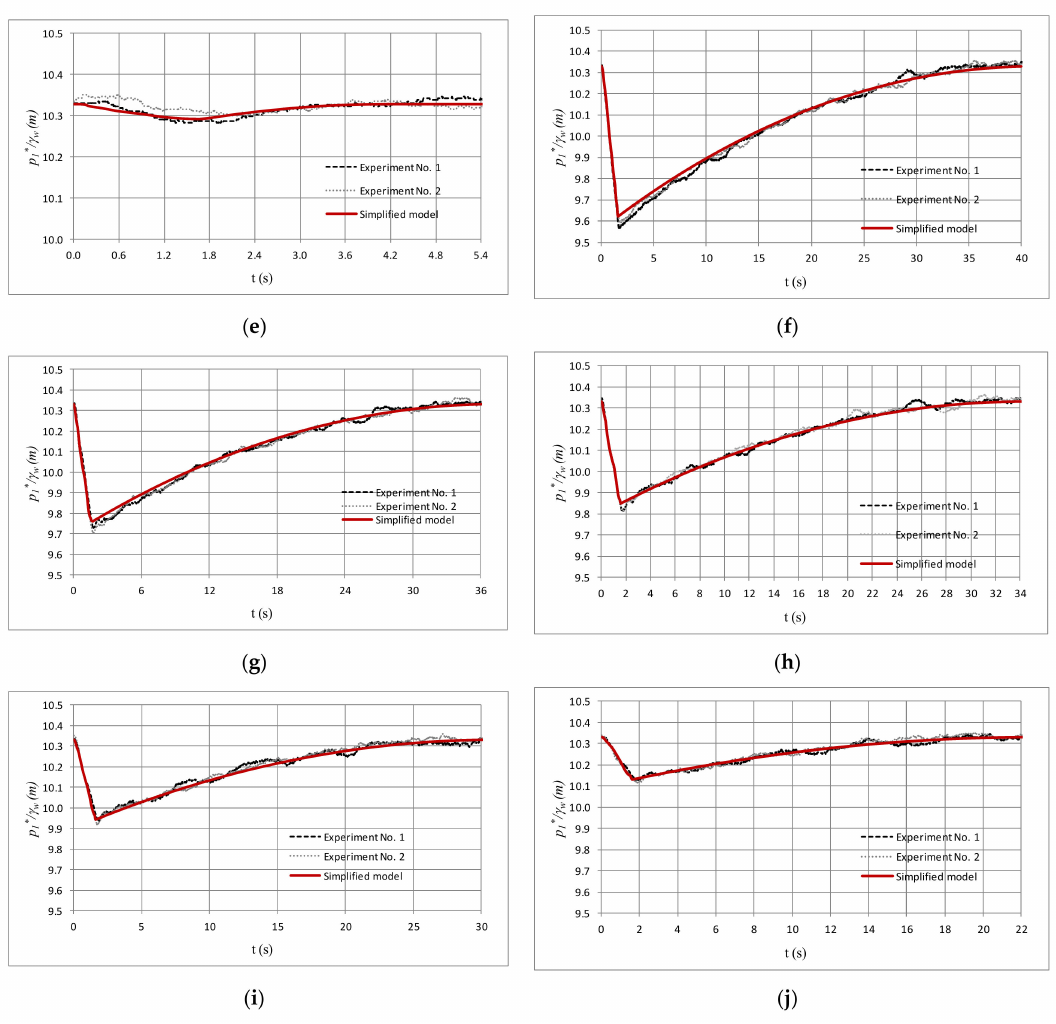
Figure 3. Comparison between measured and calculated air pocket pressure pulses, ( a ) Run No. 1; ( b ) Run No. 2; ( c ) Run No. 3; ( d ) Run No. 4; ( e ) Run No. 5; ( f ) Run No. 6; ( g ) Run No. 7; ( h ) Run No. 8; ( i ) Run No. 9; ( j ) Run No.